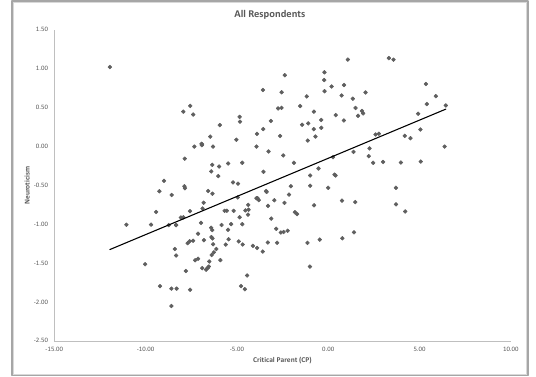
Figure 4. Moderately positive r between Adapted Child (AC) and Neuroticism.